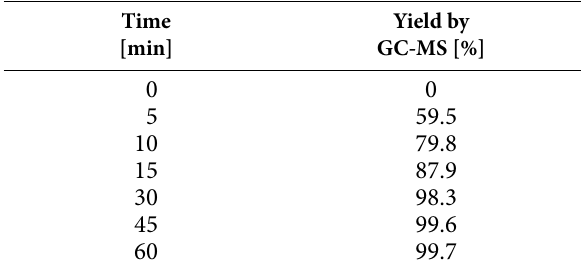
Table 3 . The time of sample withdrawn and the yield measured by GC-MS. Time Yield by